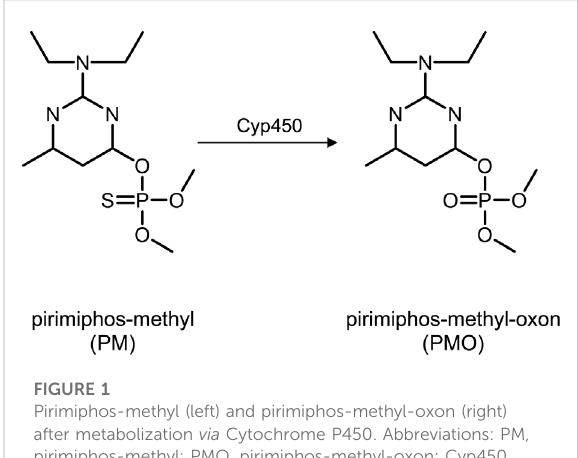
FIGURE 1 Pirimiphos-methyl (left) and pirimiphos-methyl-oxon (right) after metabolization via Cytochrome P450. Abbreviations: PM, pirimiphos-methyl; PMO, pirimiphos-methyl-oxon; Cyp450, Cytochrome